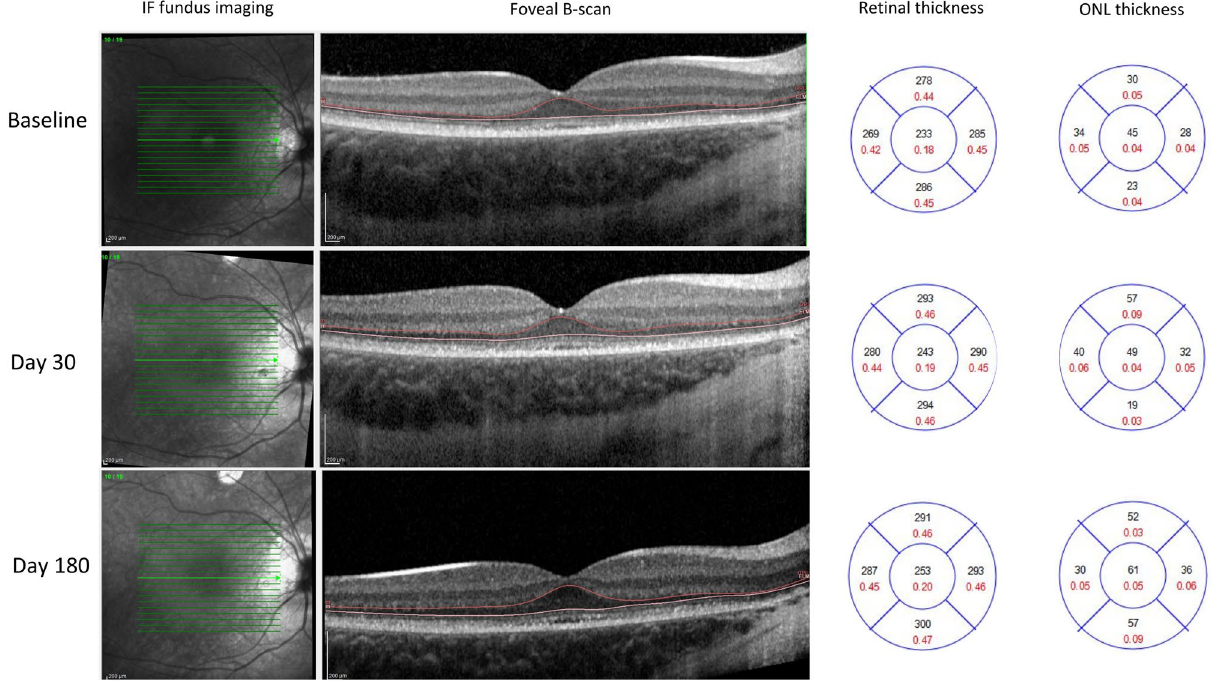
Figure 3. Retinal and outer nuclear layer (ONL) thickness analysis in the right eye of patient 6 not undergoing intra-operative foveal detachment, showing thickening of the ONL after treatment with voretigene neparvovec (VN).